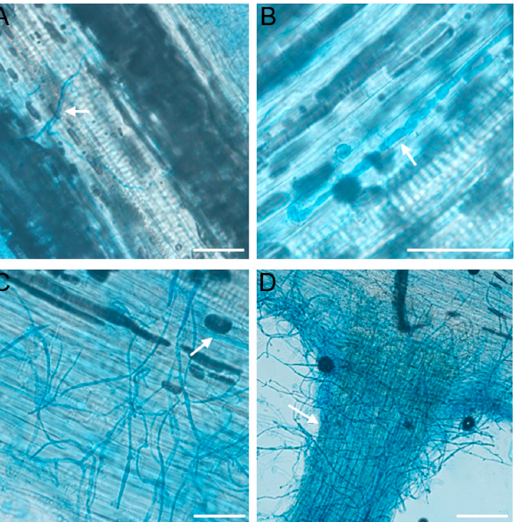
Figure 3. Symptoms, survival rates, and fresh weight of alfalfa inoculated with or without Phy- tophthora cactorum . ( A ) Growth phenotypes of alfalfa inoculated with P. cactorum or not in pot. ( B ) Survival rates and ( C ) fresh weight of alfalfa inoculated with P. cactorum or not. Data are the means of six independent experiments and error bars represent SD. Asterisks at the top of the bars indicate statistical significance (T-test, p < 0.05).